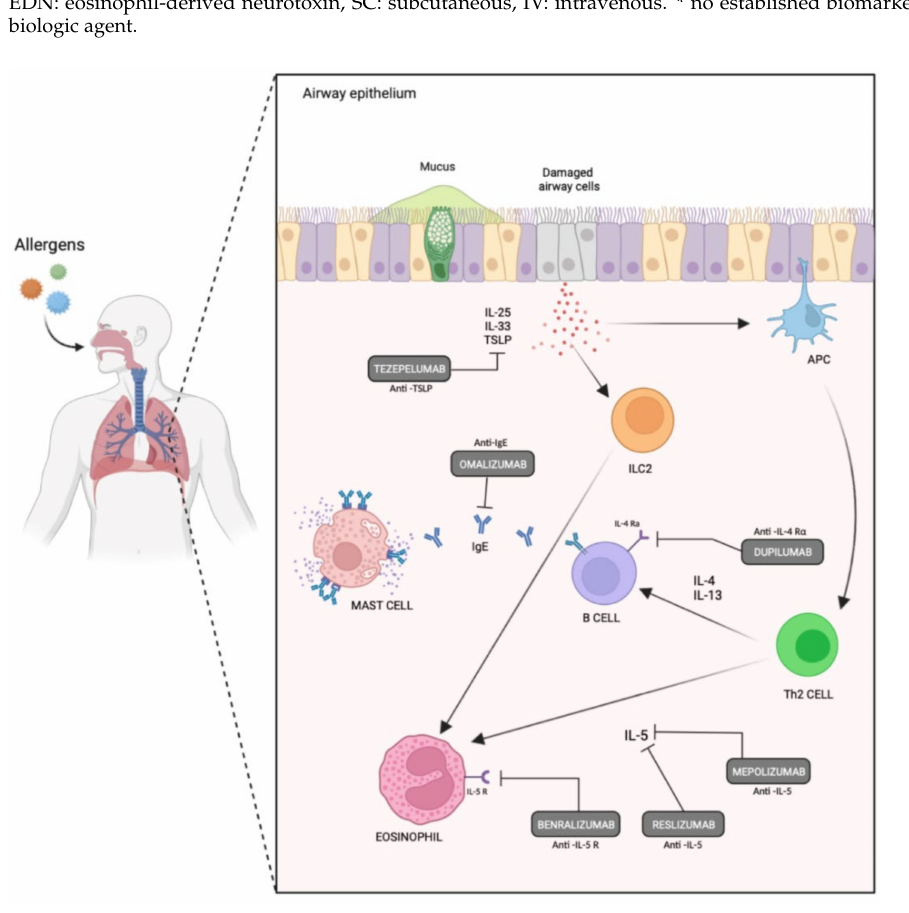
Figure 2. Currently used biologic agents and their sites of action targeting Th-2 inflammation in severe